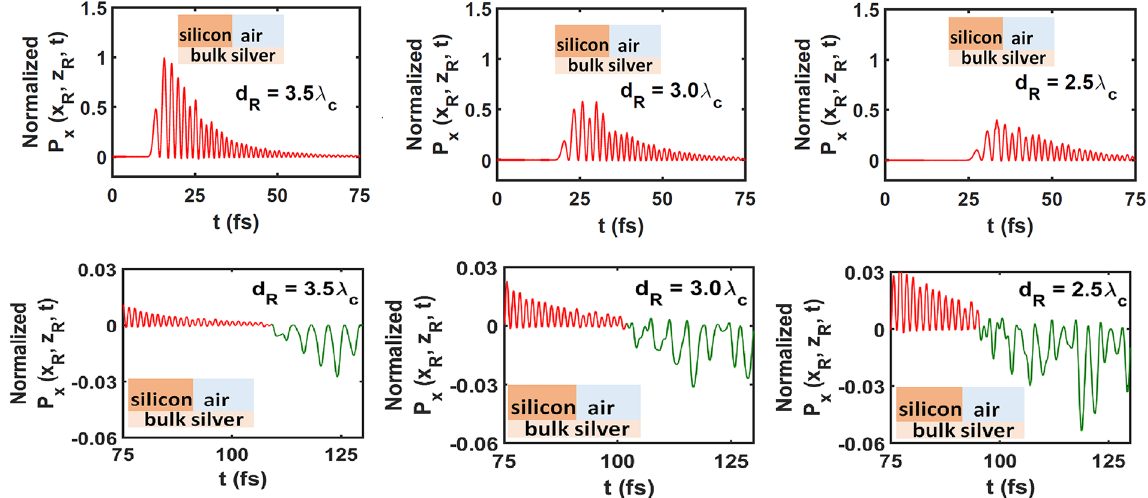
 is occupied by silver, and Figure 3. Temporal profile of normalized P x z t ( , , ) when  is occupied by air, x R R C D λ = 1200 nm λ = . , middle column: d 3 0 λ = . , and right column: d 2 5 λ = . . The top . Left column: d 3 5 c R c R c R c row shows the transmitted signal (red curve) at point R and the bottom row shows the tail of the transmitted signal (red curve) followed by the reflected signal (green curve) at point R. Multiply by 6.8 × 10 − 6 W m − 2 to obtain unnormalized P x z t ( , , ) . x R R